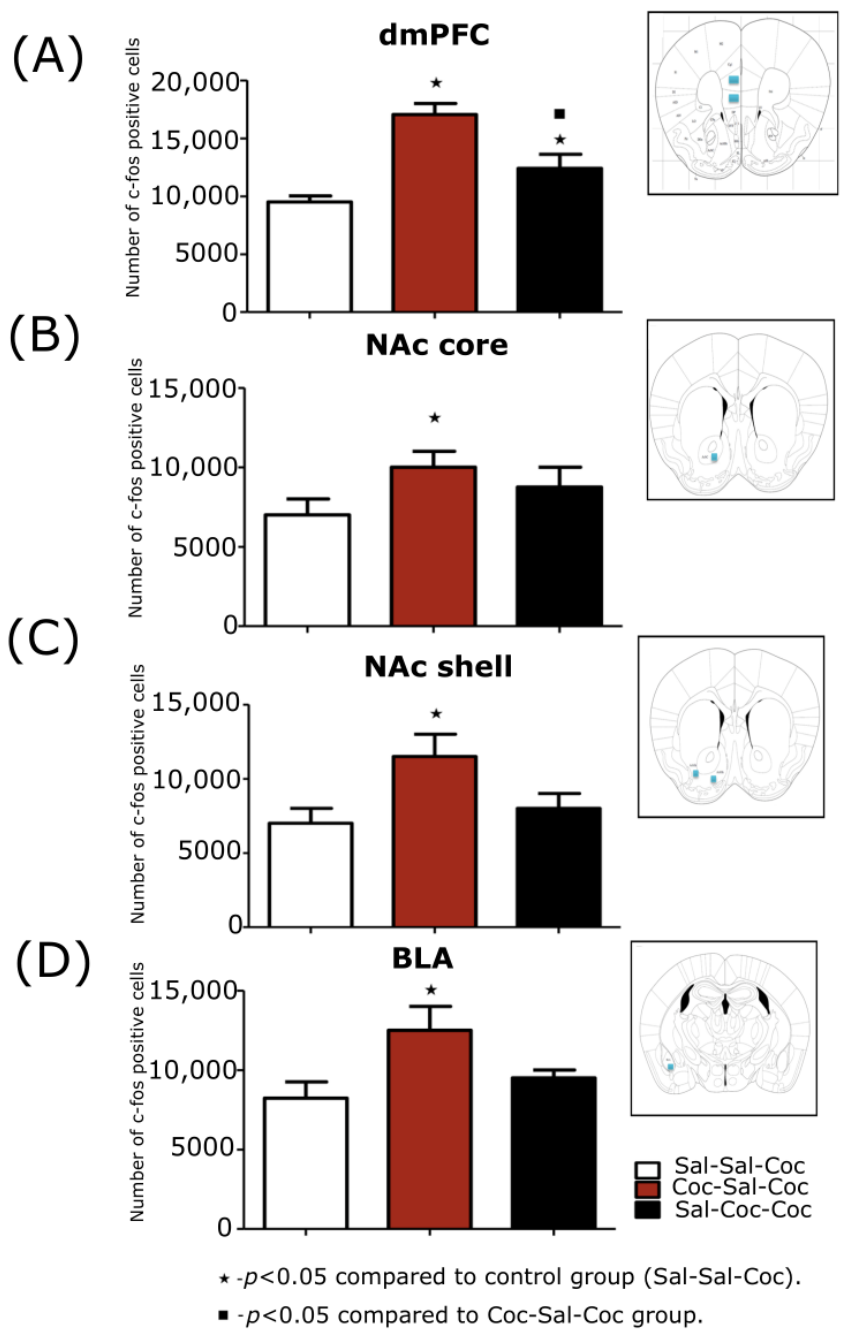
Figure 5. Stereological analysis of the expression c-Fos protein in animals treated with cocaine, administered in a paired way (Coc-Sal-Coc) or not (Sal-Coc-Coc) to the environmental context in the expression phase in the following structures: ( A ) The dorsomedial prefrontal cortex (dmPFC) measurements were performed at 1.95 mm of bregma, a representative area of quantification is ob- served by the blue rectangles on the right. ( B ) The nucleus accumbens core (NAc core) measurements were performed at 1.88 mm of bregma, a representative area of quantification is observed by the blue rectangle on the right. ( C ) The nucleus accumbens shell (NAc shell), measurements were performed at -1.18 mm of bregma, a representative area of quantification is observed by the blue rectangles on the right. ( D ) The basolateral amygdala (BLA), measurements were performed at -1.22 mm of bregma, a representative area of quantification is observed by the blue rectangle on the right. The number of c-Fos positive cells is expressed as mean ± SEM. The one-way ANOVA test was performed, followed by the Duncan post hoc